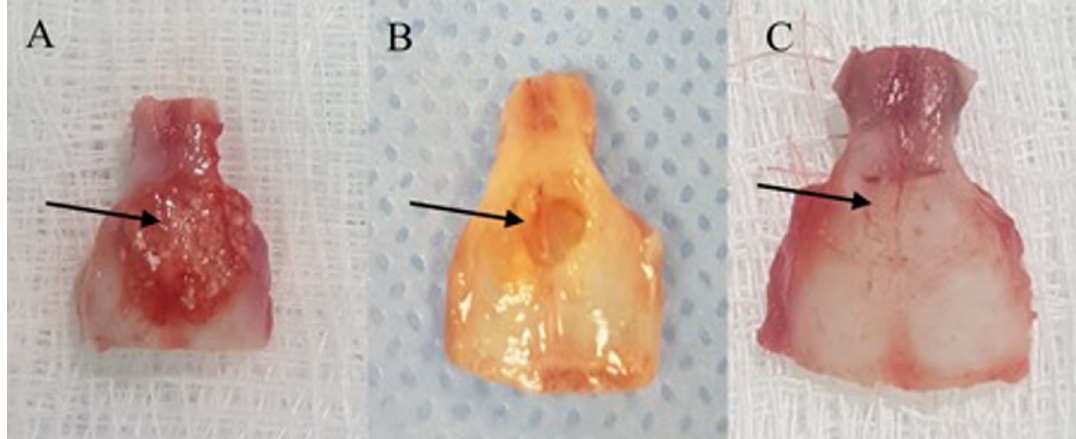
Fig. 2 Different harvested calvarial bone from the tested groups. A Group 1: corticated bone grafted with SCPC/DMS/hBMSC, B Group 2: critical size defect grafted with SCPC/DMS/hBMSC, and C Group 3: corticated bone grafted with DMS